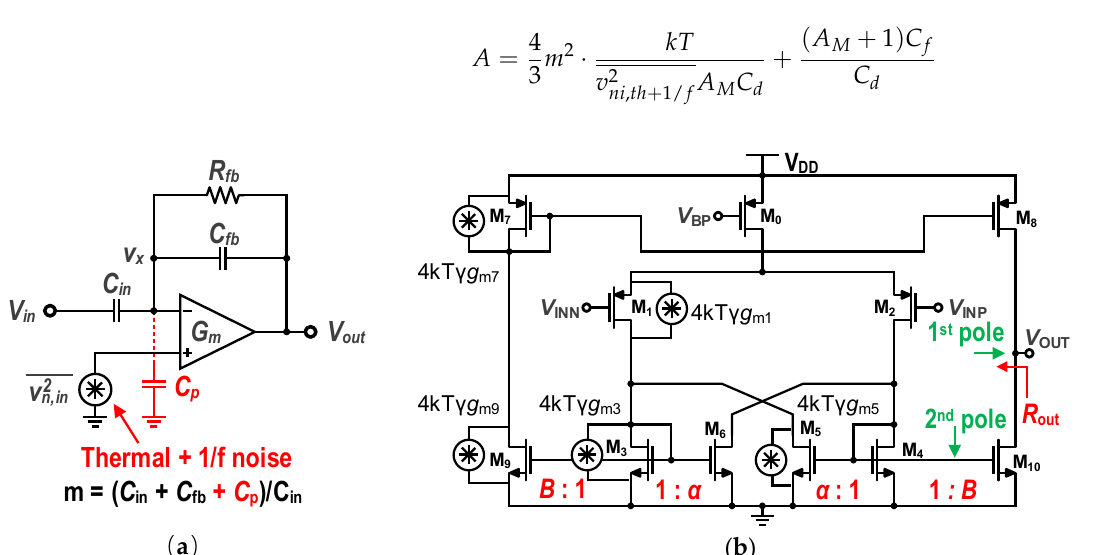
Figure 3. Proposed LNA structure: ( a ) A single-ended input and output LNA used for the pixels in the proposed 16-channel AC-coupled neural recording frontend; ( b ) the transconductor ( G m ) used for the LNA.